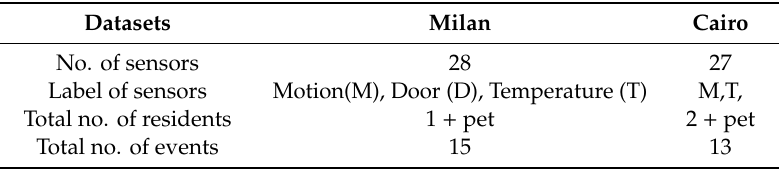
Table 1. CASAS datasets information.